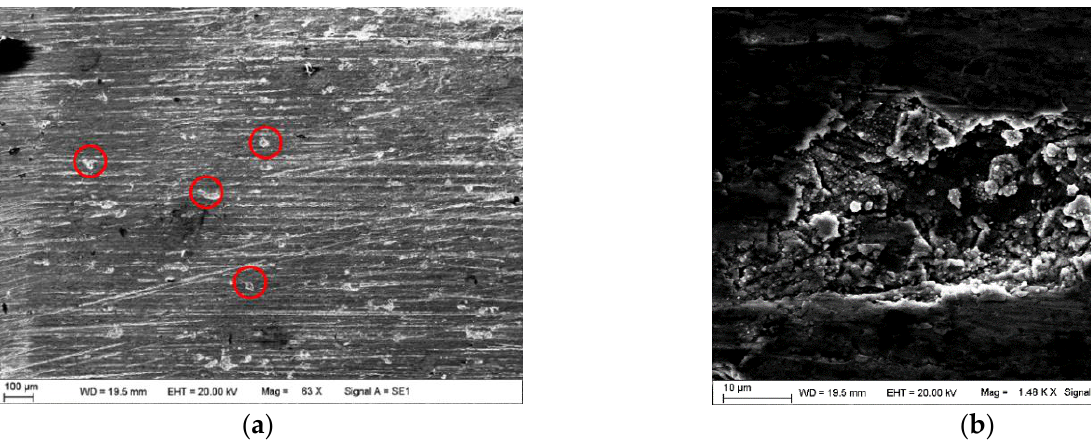
Figure 8. Pitting corrosion on the fretting surface. ( a ) The 63 times magnification; ( b ) the 1480 times magnification.